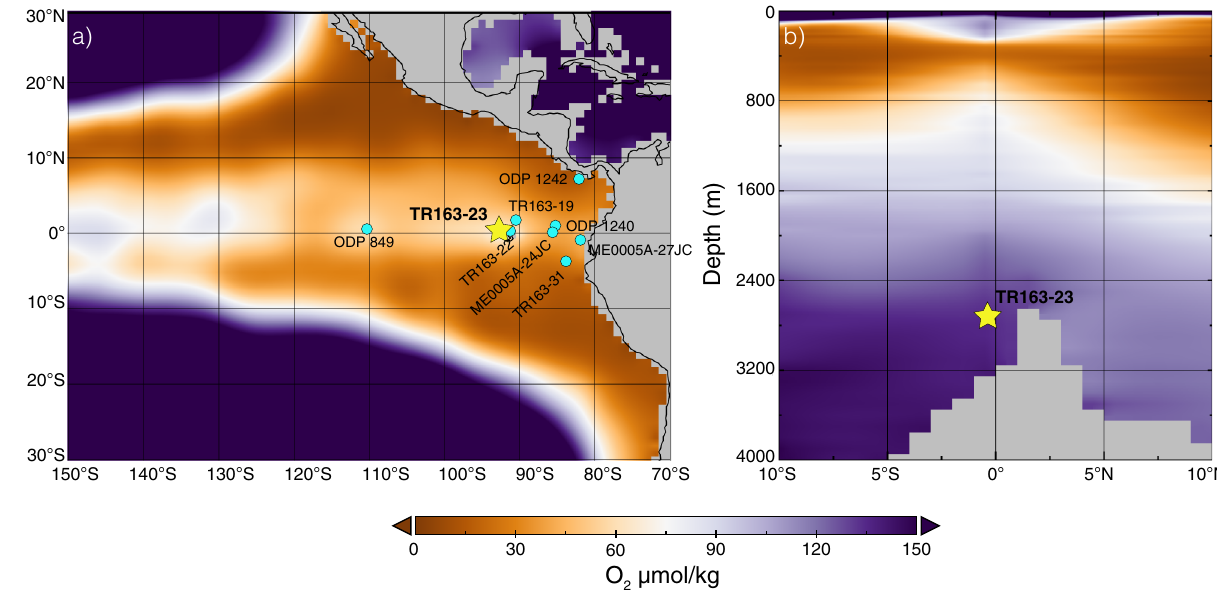
Fig. 1 Spatial distribution of oxygen in the Eastern Equatorial Paci fi c. a Shows O 2 at 250m depth and the location of TR163-23 (yellow star) as well as other core sites discussed here (blue circles). b Shows a section of O 2 with depth along the 92°W meridian showing the location of TR163-23. Oxygen data was sourced from WOA18 73 .